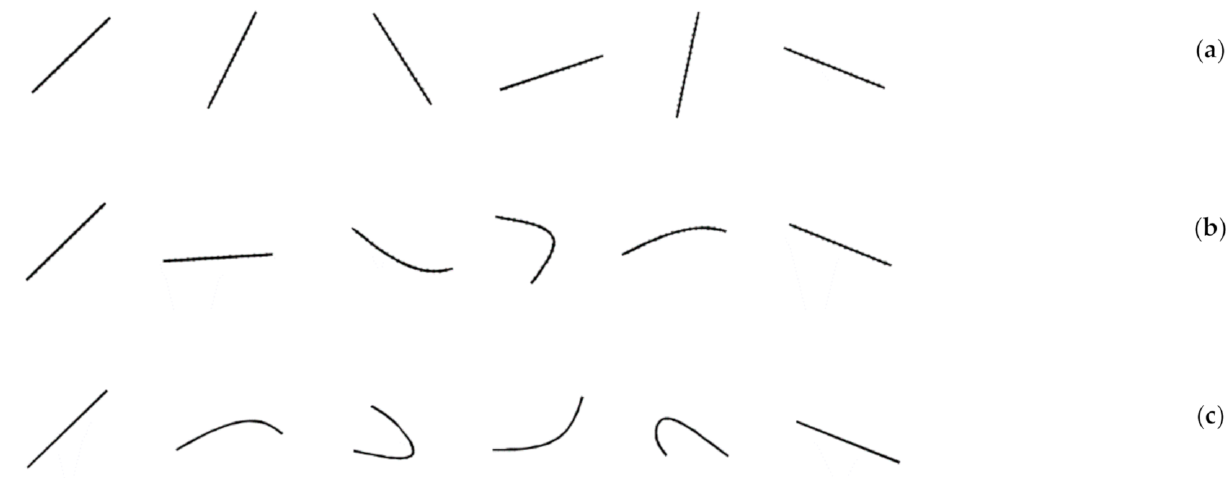
Figure 7. Time sequence of images from the simulation for various dimensionless shear rates: ( a ) γ ∗ = 1.43 × 10 − 4 , ( b ) γ ∗ = 7.2 × 10 − 4 , and ( c ) γ ∗ = 3.2 × 10 − 3 .